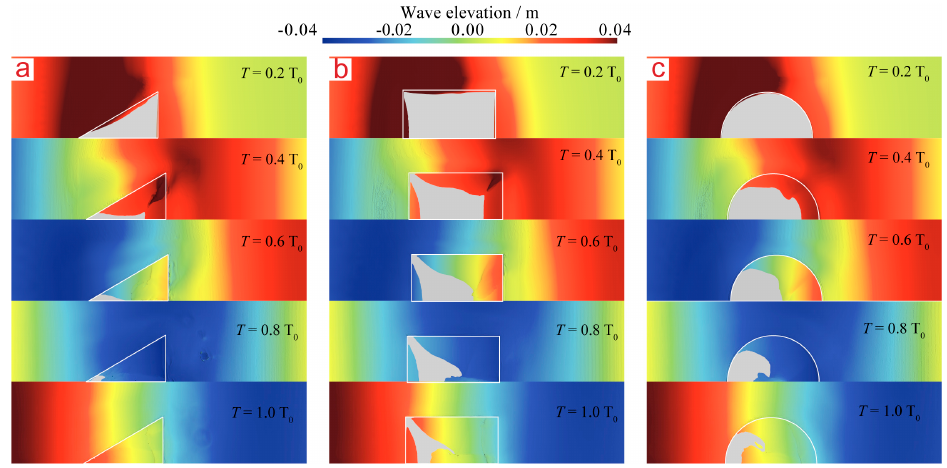
Figure 13. Wave elevation at different times (T) after wave–ice floe interaction. ( a ) Triangle ice floe; ( b ) Square ice floe; ( c ) Circle ice floe.